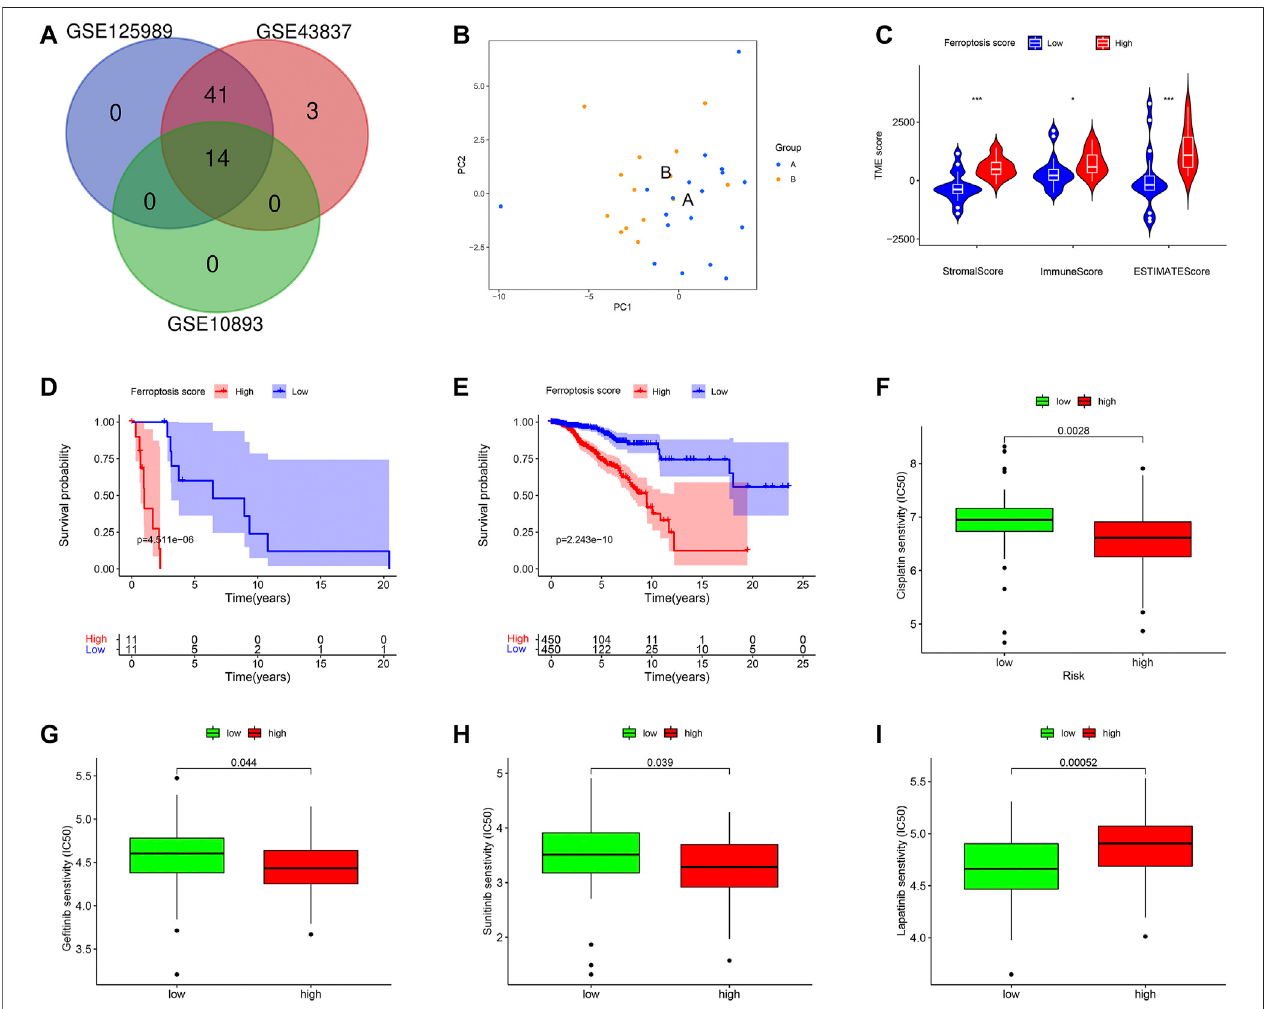
FIGURE 10 | External validations based on ferroptosis. (A) The venn graph demonstrated there were 14 intersection FRG among the three datasets. (B) Principal componentanalysistoclassifypatientswithBCBMaccordingtotheferroptosis. (C) Patientsinhigh-ferroptosishadhigherstromalscore,immunescoreandESTIMATE score. (D) K-Msurvivalplotforpatientswithhigh-andlow-ferroptosisscoresinmetastaticgroup. (E) K-M survivalplotforpatients withhigh- andlow-ferroptosisscores in non-metastatic group. Drug sensitivity analysis of Cisplatin (F) , Ge fi tinib (G) , Sunitinib (H) , and Lapatinib (I)